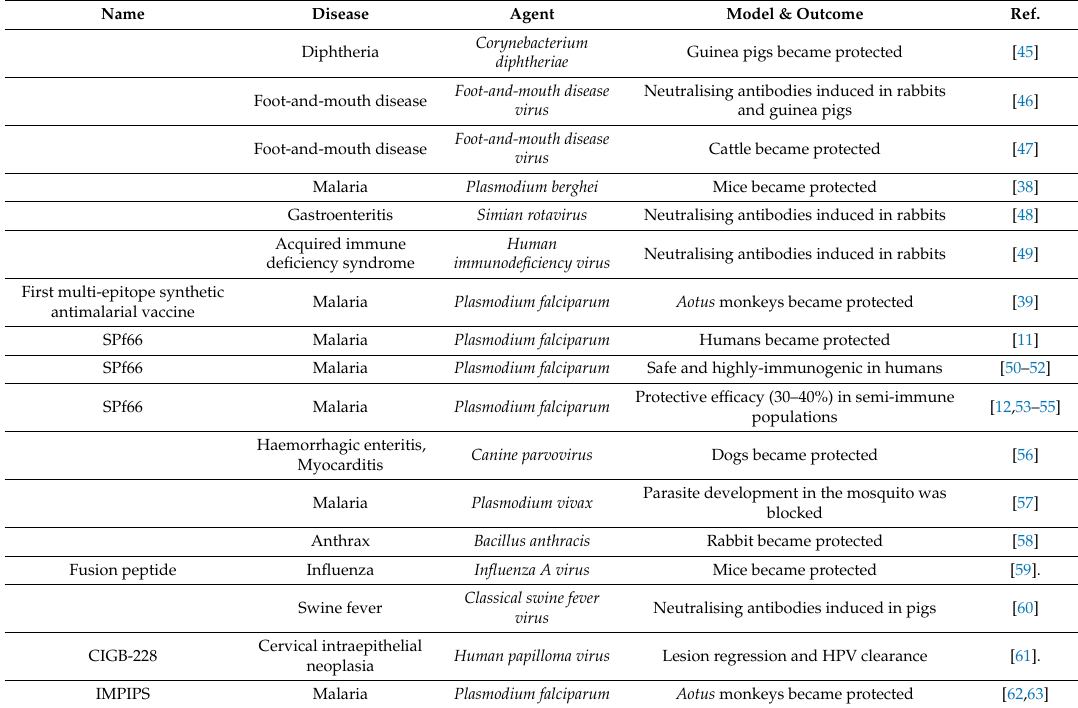
Table 1. Synthetic peptides as